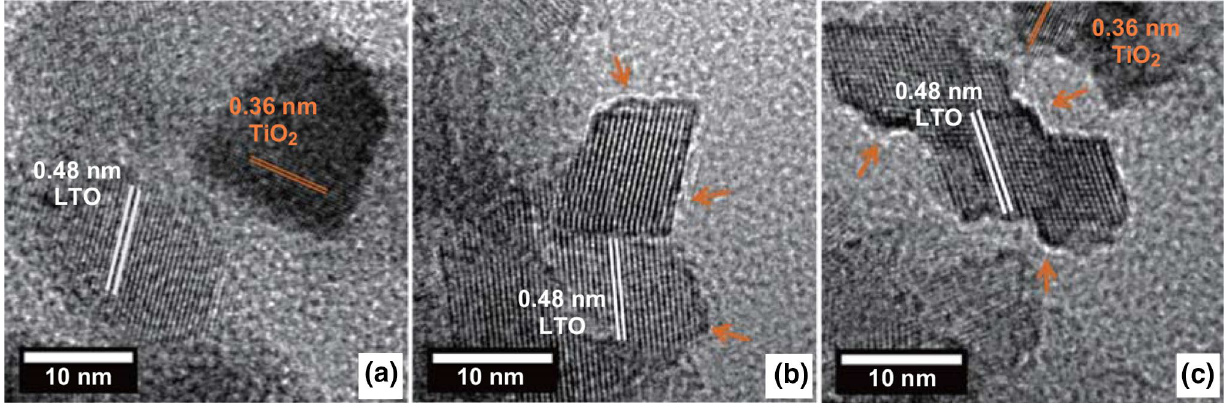
Fig. 2 High-resolution TEM analysis of the fabricated materials. a Unaged LTO with both LTO and TiO 2 phases, b aged LTO with a disordered surface layer (indicated by arrows), and c aged LTO-3.5 with both disordered surface layer (indicated by arrows) and TiO 2